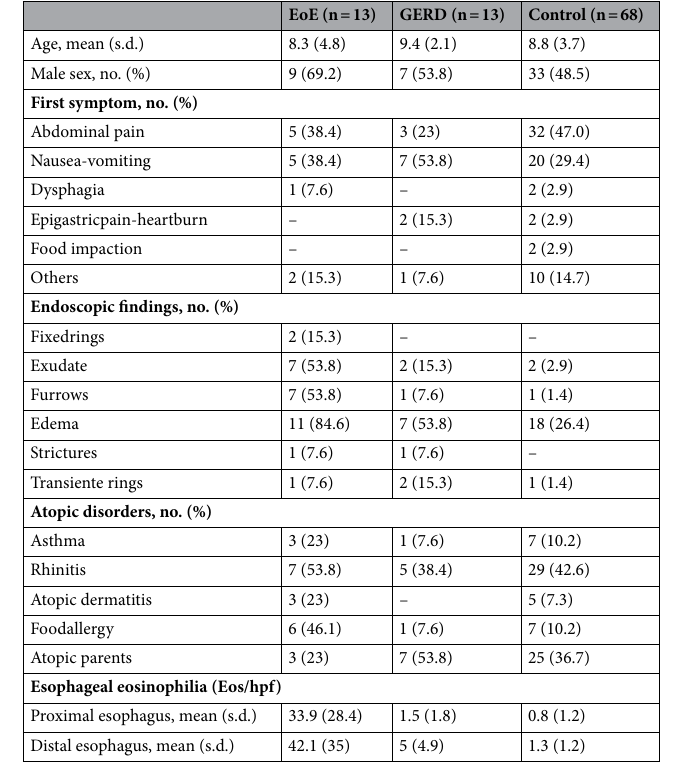
Table 1. Baseline characteristics of patients included in the study. EoE eosinophilic esophagitis, GERD gastroesophageal reflux disease, Eos/hpf eosinophils per high-power